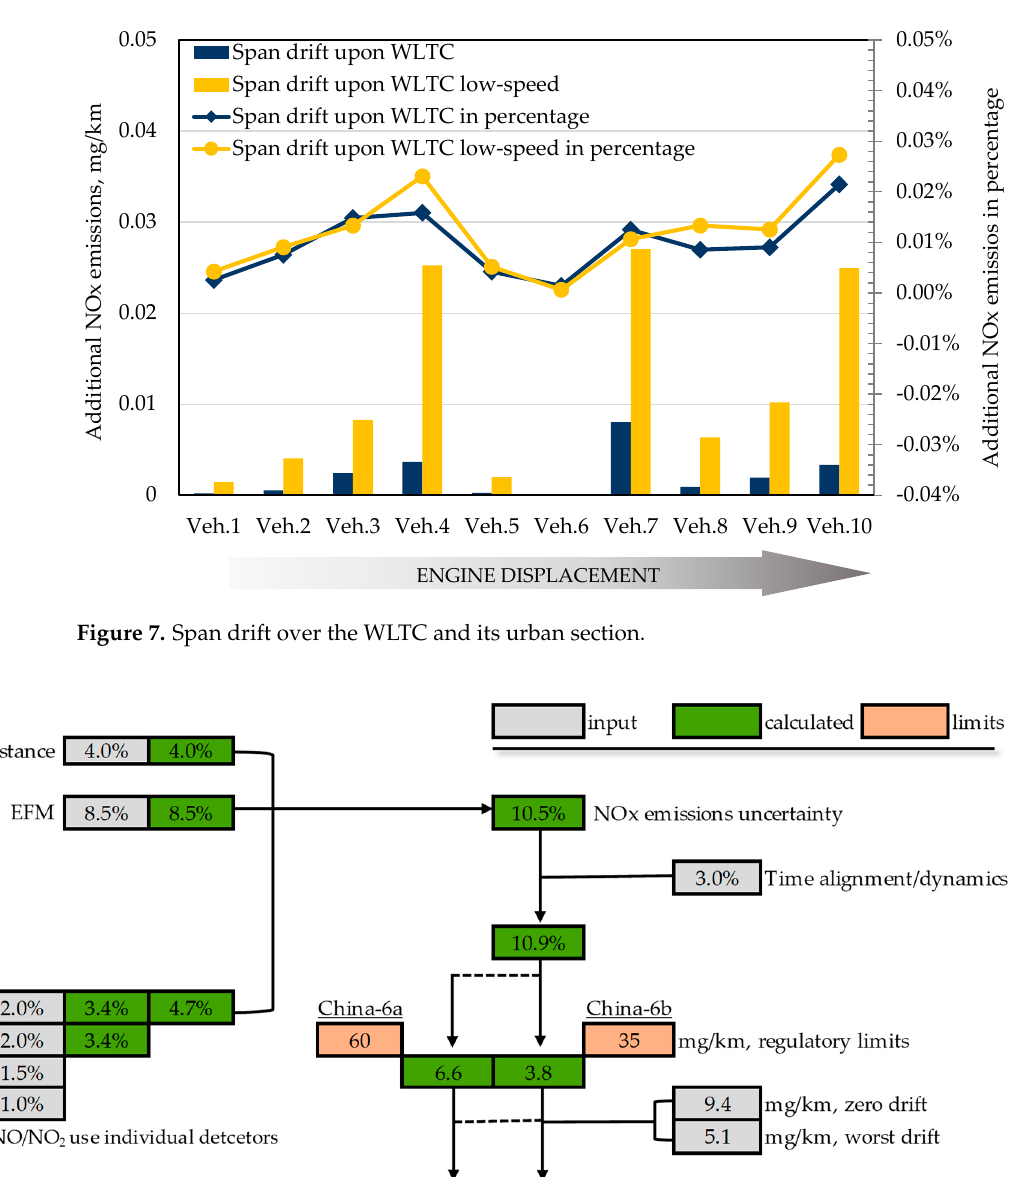
10 of 14 Figure 6. Statistical distribution of span drift events up to a certain concentration level. In agreement with the JRC’s assumption of span drift, the span drift was assumed to be linear, with 0% at 0 ppm and 1.5% at the span concentration. We took 1.5% of the span